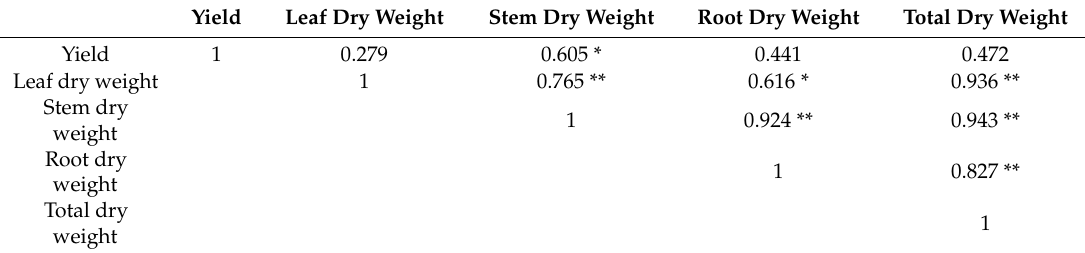
Table 7. Correlation analysis between tomato yield and dry